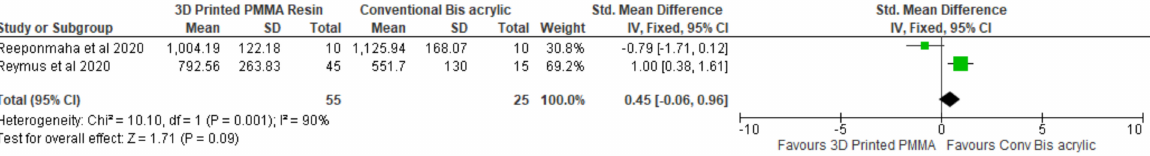
Figure 9. Forest plot comparing surface roughness between 3D-printed PMMA resin and conventional bBis-acrylic